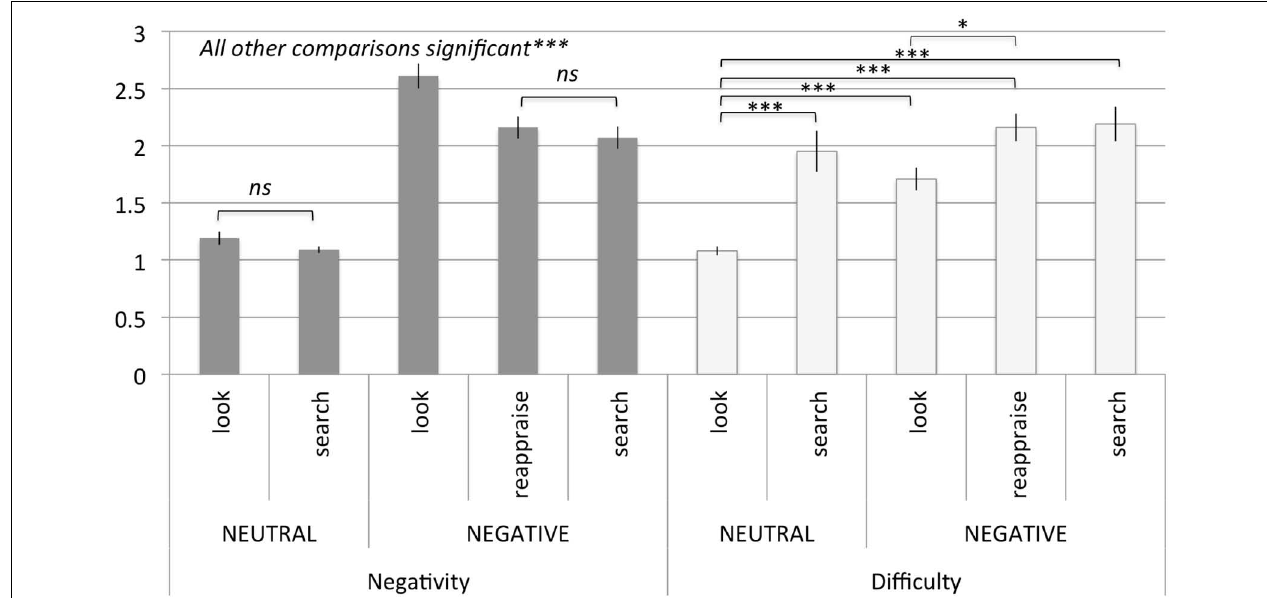
FIGURE 2 | Study1: averages and standard errors of negativity (gray bars) and difficulty ratings (white bars) for the different instruction conditions for neutral and negative pictures ( N = 22). * p < 0.05, ** p < 0.01, *** p < 0.001.